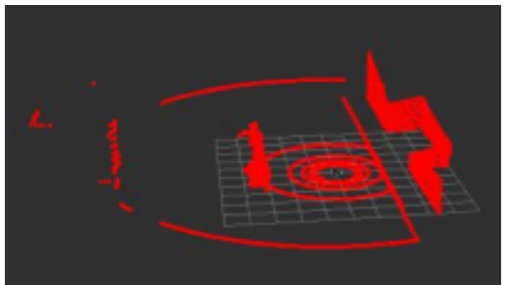
Figure 2. Original point